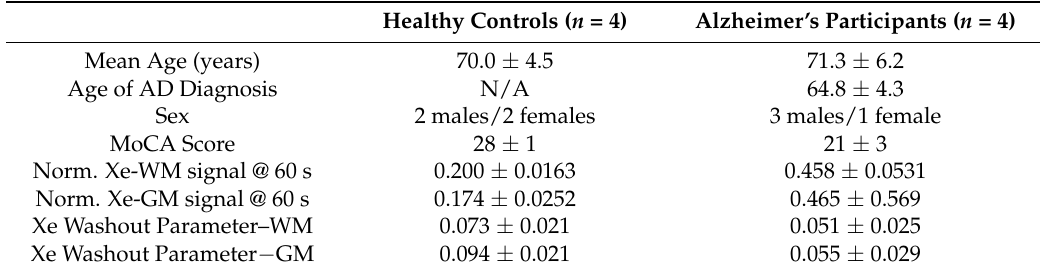
Table 1. Statistics of healthy controls & Alzheimer’s disease (AD) Characteristics ±